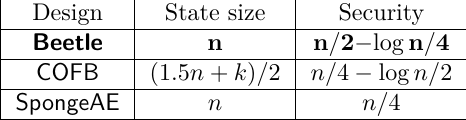
Table 1: Comparative Study on the State size and Security Trade-off: for all the con- structions, we have assumed that n/ 2 bits message is processed per primitive call. Here SpongeAE refers to the AE mode using traditional duplex sponge